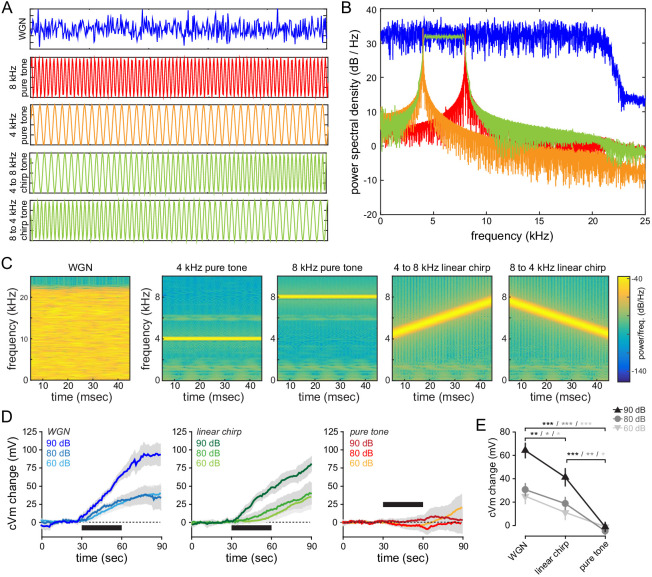
Spectral properties of the auditory tones used in our study, and their effect on membrane potential of FrA L2/3 pyramidal neurons.(A) 50 ms-long pips (sampling frequency: 44100 Hz) were generated by producing 2205 samples (i) following a Gaussian distribution for WGN, (ii) of a sinusoidal signal for pure tones, and (iii) of a swept-frequency cosine signal for linear chirp tones. For clarity, pips have been cut at 10 ms in the figure. Each presented sound lasts 30 s and is composed of 27 pips (50 ms each). (B) Power spectral density obtained by Fourier Transform of digitalized WGN (blue), pure 4 kHz (orange) and 8 kHz (red) tones, and linear chirp tones (green). Note that the power spectral density of WGN is constant (flat) across all the frequencies below 20 kHz (the signal is low pass filtered to avoid aliasing and ultrasonic frequencies that generate innate defensive behaviors). (C) Spectrograms generated by the short-time Fourier transform of a single pip (50 ms). (D) Averaged cVm change (±sem) evoked by WGN, linear chirps (4-to-8 kHz and 8-to-4 kHz pooled together), and pure frequency tones (4 and 8 kHz pooled together), at different intensities. All tones and intensities were tested on the same cell (n = 6 cells). Black bar, 30 s-long sound (27 pips). (E) Mean cVm change at the end of the tone presentation (t = 60 s).Figure 1—figure supplement 1—source data 1.Spectral and sound pressure properties.